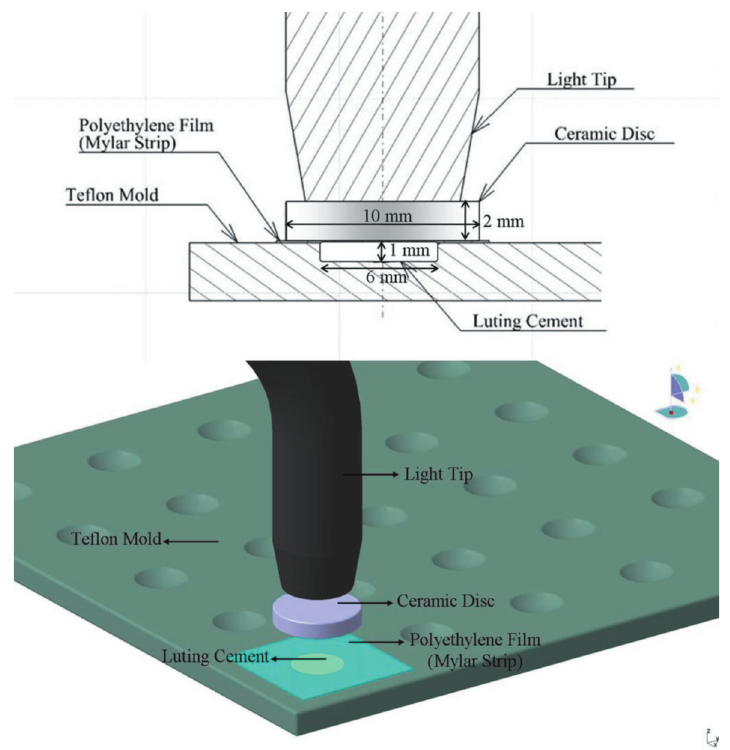
Figure 2- Schematic illustration of sample